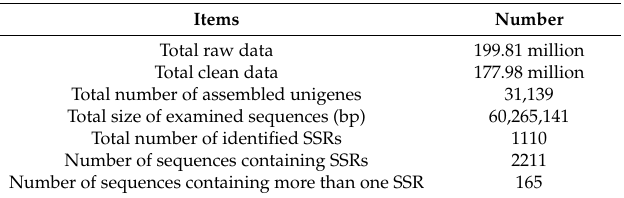
Table 3. General summary of Bailinggu transcriptome sequencing.